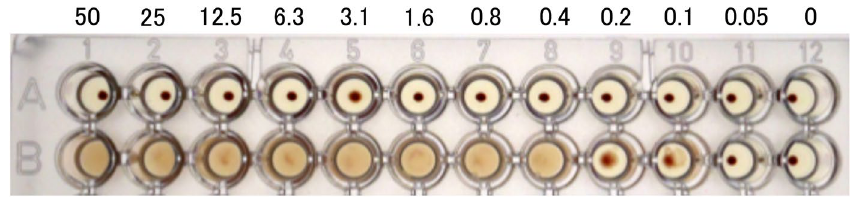
Figure 6. Haemagglutination assay. Lectin concentration is shown in μ g/mL. Mitsuba-1 (top row) showed no lytic effect on the red cells at any concentration tested, up to 50 μ g/mL. MytiLec-1 (bottom row) showed agglutination at concentrations down to 0.1~0.2 μ